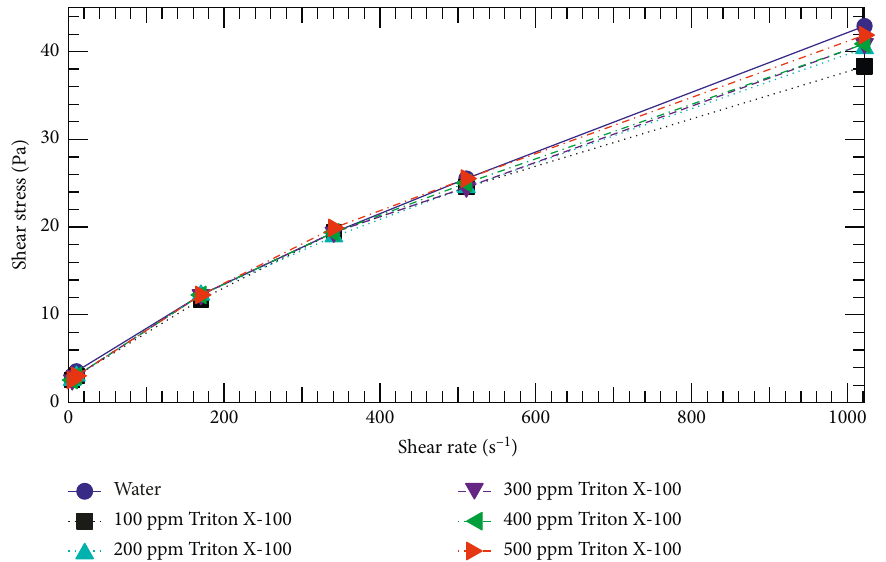
Figure 10: Rheogram of water-based drilling fluid with 0.1ppb of graphene nanoplatelets dispersed using Triton